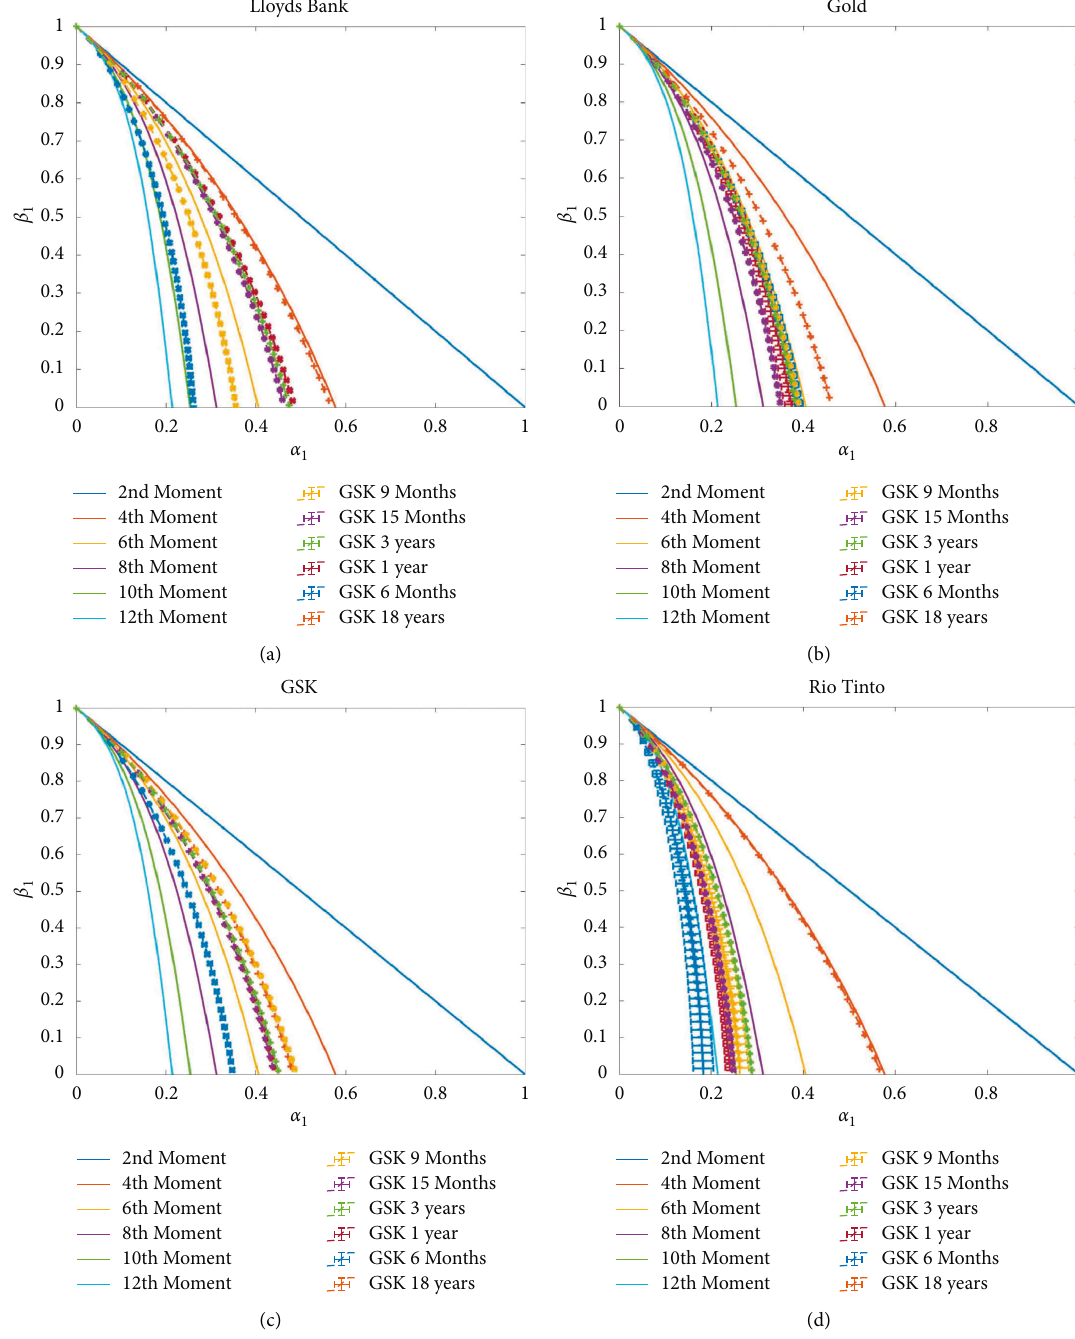
Figure 3: The stability phase diagram for the GARCH-normal (1,1) moments with an overlap of several company trajectories. (a) The trajectory for Lloyds Bank, where the shortest time window allows up to the tenth-order moment to exist. (b) The trajectory of Gold ETFs (Exchange Traded Funds), where the shortest time window allows to the sixth moment to exist. (c) The same for GSK, which allows up to the sixth moment to exist and lastly. (d) The same for Rio Tinto, which allows up to the twelfth-order moment to exist. We also show the error intervals of the trajectories, see Appendix A for